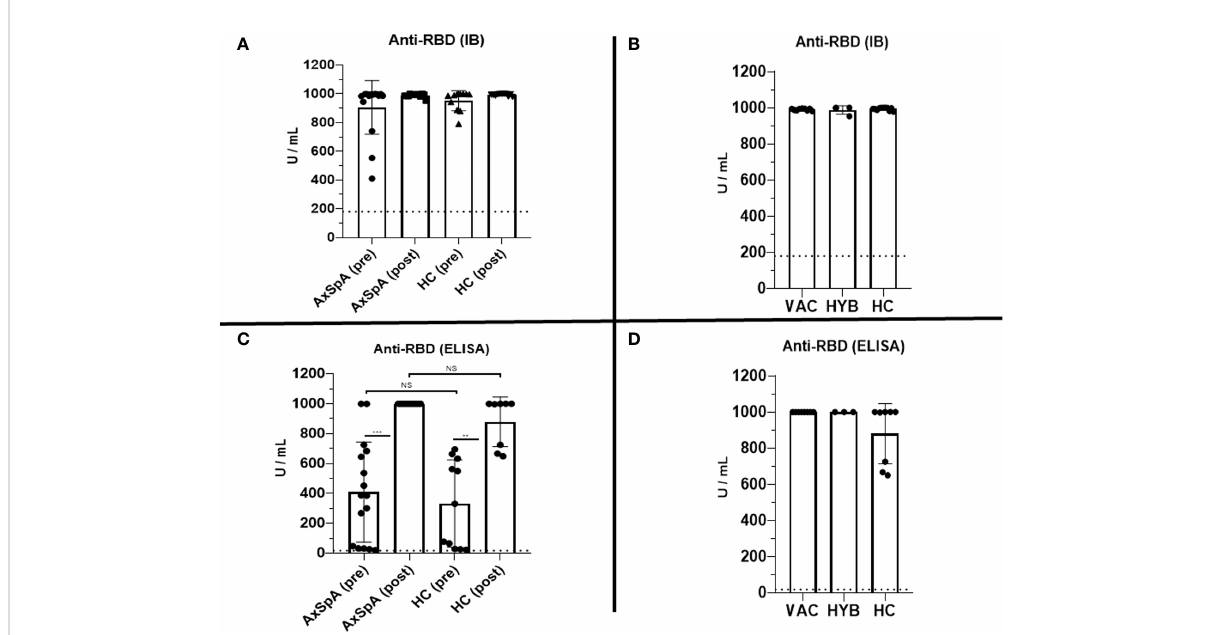
FIGURE 2 Pre-dose (6 months after completing the primary vaccination scheme) and post-dose (1 month after booster vaccination) humoral immune responses were measured as the serum concentration of anti-RBD-speci fi c antibodies (U/mL) using Immunoblot [IB, (A) ] and ELISA (C) in the cohorts of axial spondyloarthritis (AxSpA) and healthy control (HC) cohorts, “ vaccinated only ” (VAC) and “ hybrid immunity ” (HYB) AxSpA subgroups (B, D) ; positive cutoff values (>180 U/mL for IB and >18 U/mL for ELISA) are marked as dashed line; statistically signi fi cant differences are marked as **p < 0.01, ***p < 0.001,, NS (not signi fi cant) >0.05.